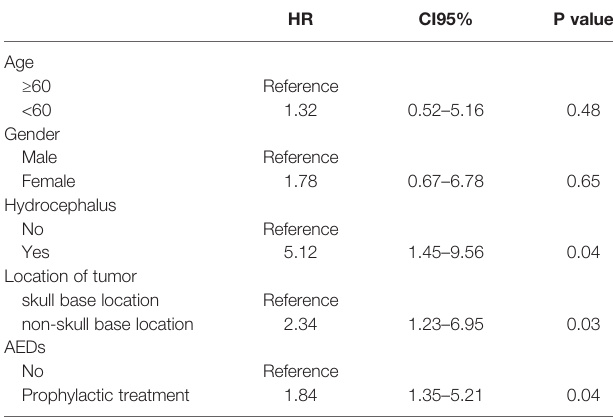
TABLE 4 | Multivariate logistic regression analysis of study population excluding the patients with seizure attack before